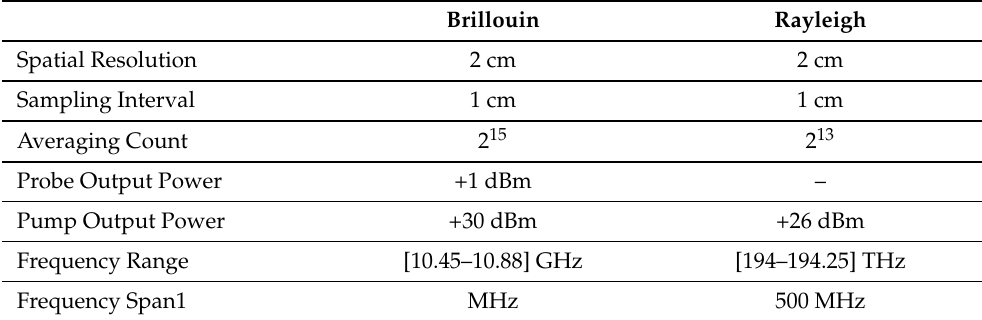
Table 1. Measurement